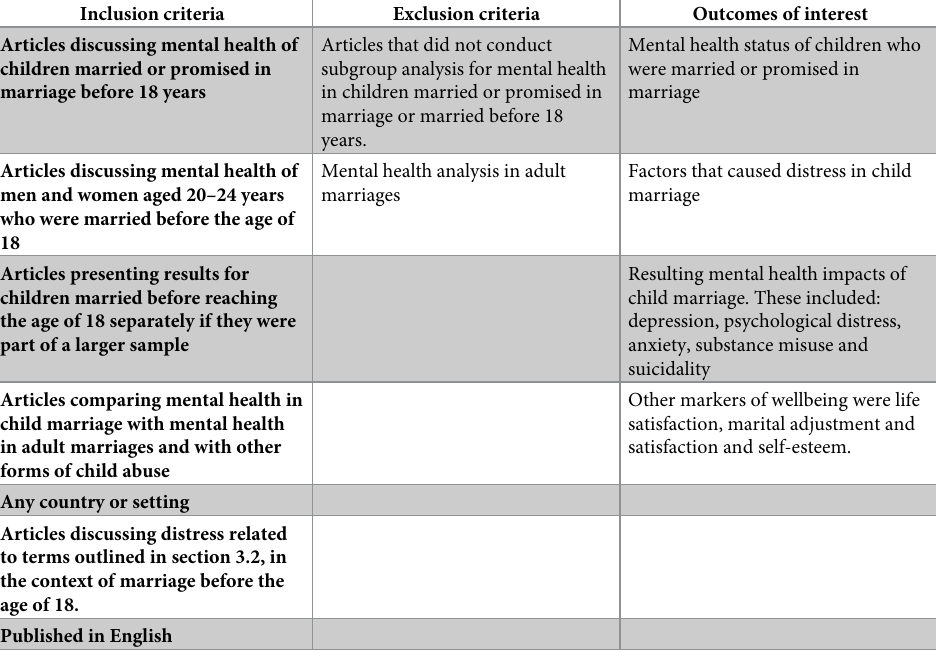
Table 2. Inclusion and exclusion criteria, and outcomes of